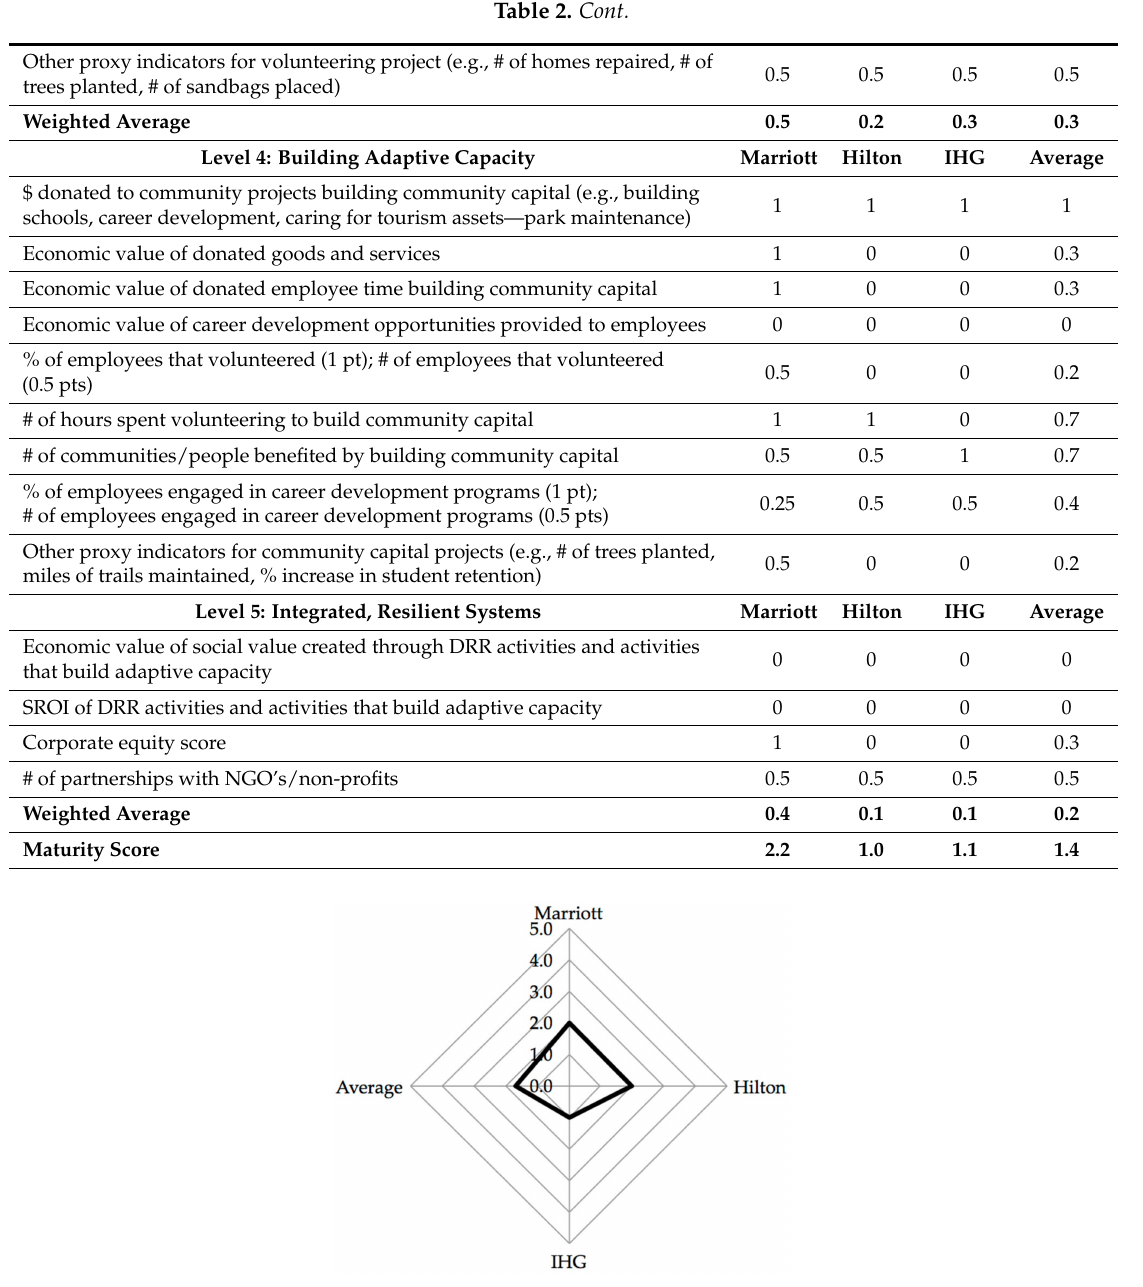
Figure 6. Maturity scores from metric analysis of the hotel and lodging